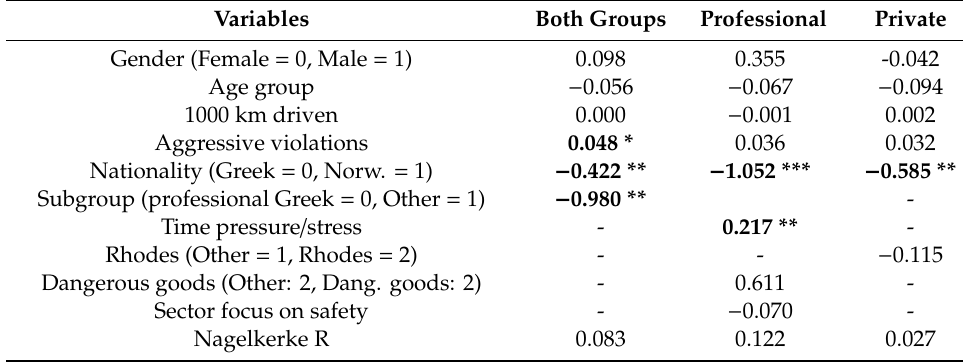
Table 13. Logistic regression analyses for three groups. Dependent variable: “Accidents (No = 0, Yes = 1)”. Beta values. Variables Both Groups Professional